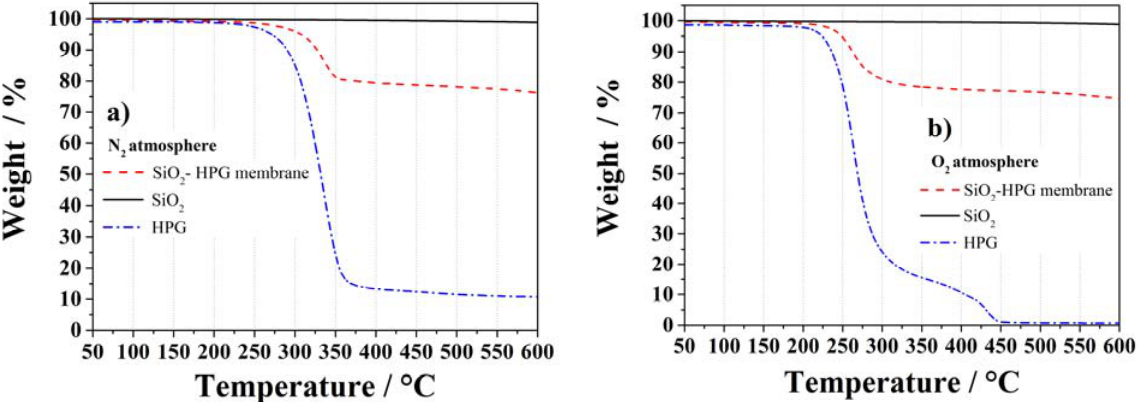
Figure 4. TGA measurements of HPG, SiO 2 particles and the SiO 2 –HPG membrane in nitrogen ( a ) and oxygen ( b ) atmospheres.